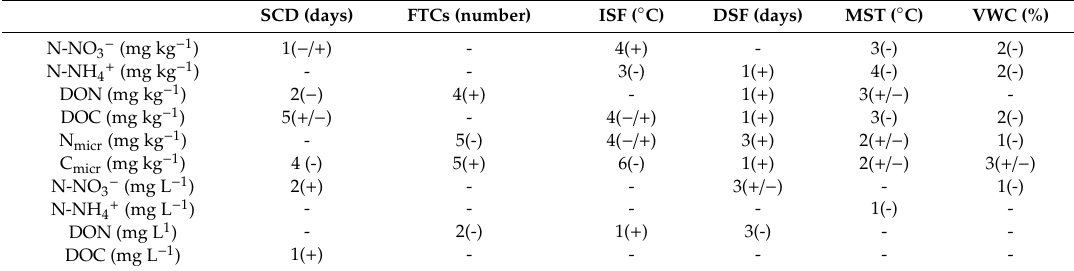
Table 5. Random Forest rankings of the e ff ect of the main abiotic factors on C and N forms. SCD (days) FTCs (number) ISF ( ◦